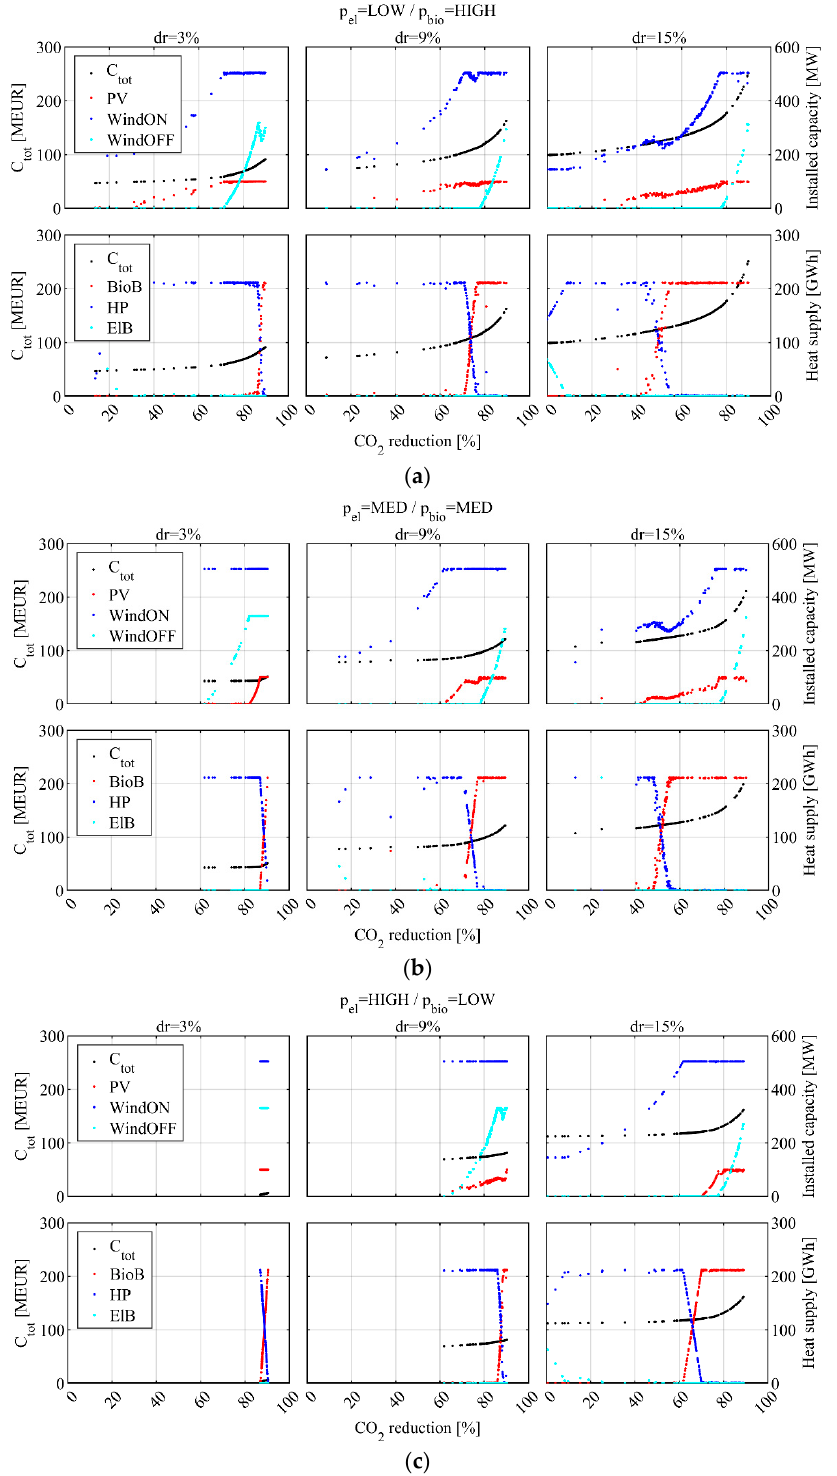
Figure 5. Electricity and heating sectors, on top: ( a ) for the combination p el = LOW/ p bio = HIGH, in the middle: ( b ) with p el = MED p io = MED, bottom: ( c ) with p el = HIGH/ p bio = LOW. Optimal results with all decision variables for the electricity sector in rows 1, 3, and 5 (PV, WindON and WindOFF), decision variables for the heating sector in rows 2, 4, and 6 (BioB, HP, ElB), C tot in all diagrams, nine cases in total for sensitivity analysis on p el / pbio and dr .